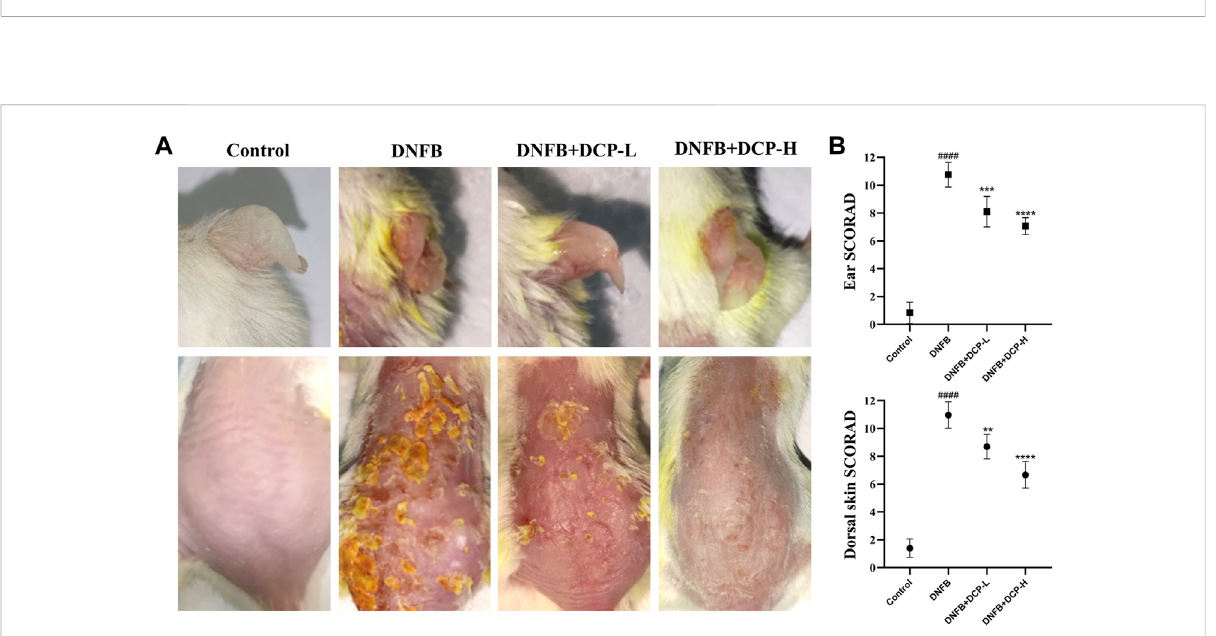
FIGURE 3 Effects of DCP on the dorsal skin and ear lesions (A) , clinical score measurements (B) . The dermatitis SCORAD (mean ± SD) for the dorsal skin and ear from each mouse analyzed by n = 5 independent investigators in a randomized blinded fashion from 0 (no) to 12 (severe). Each SCORAD represents the mean ± S.E.M. of 5